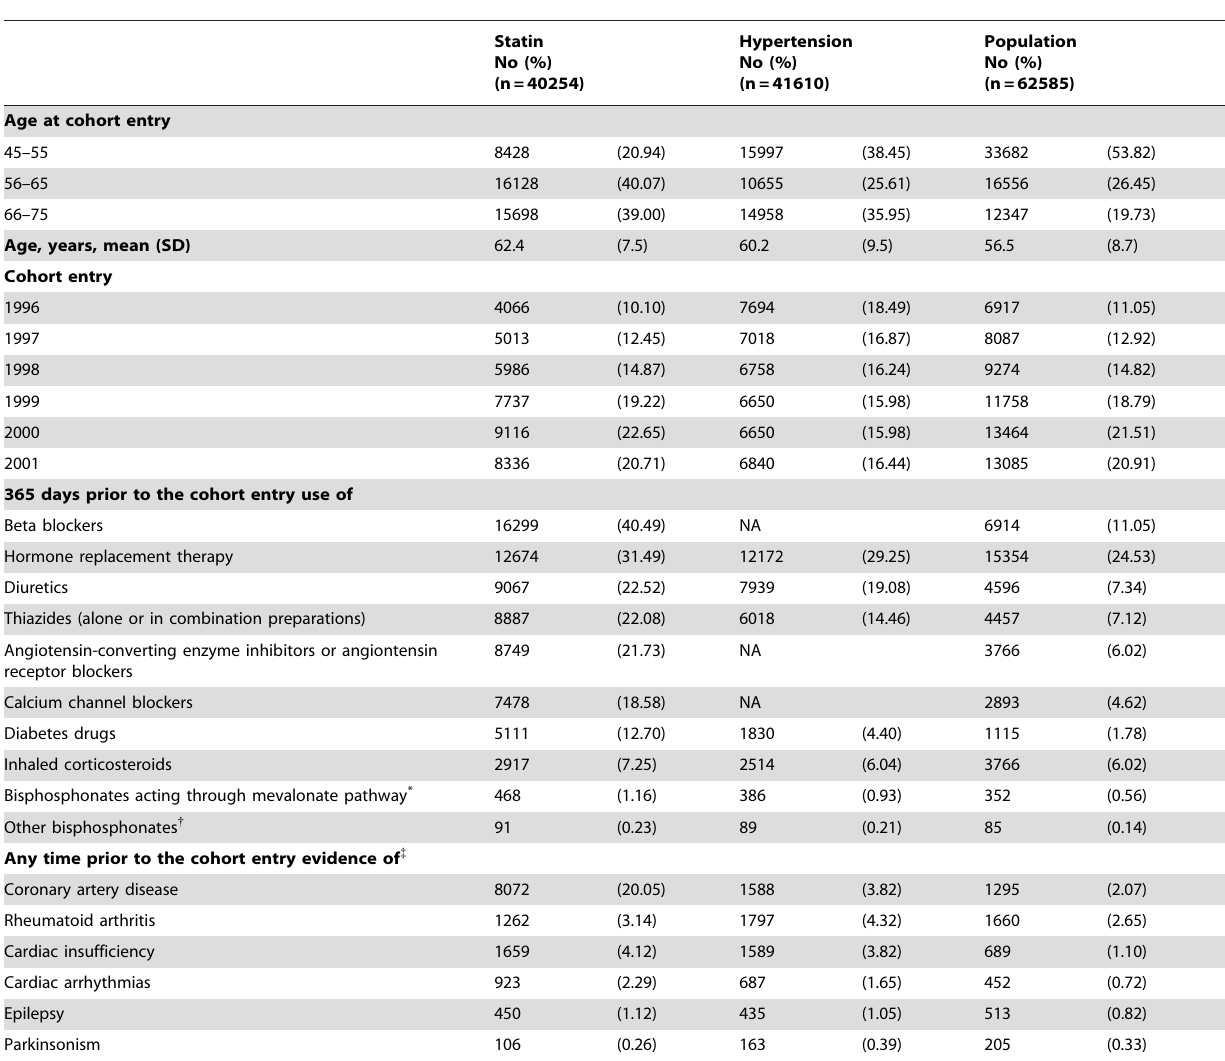
Table 1. Selected characteristics of the persons in the study